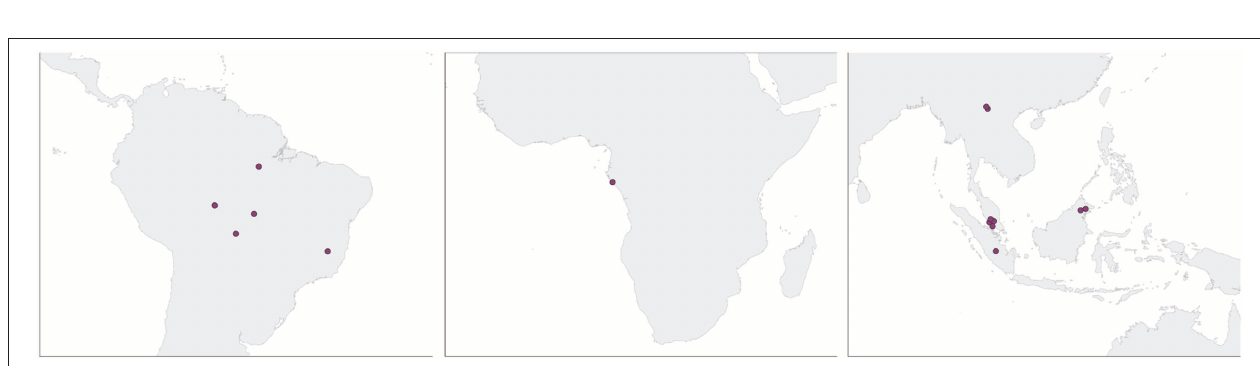
Frontiers in Ecology and Evolution | www.frontiersin.org